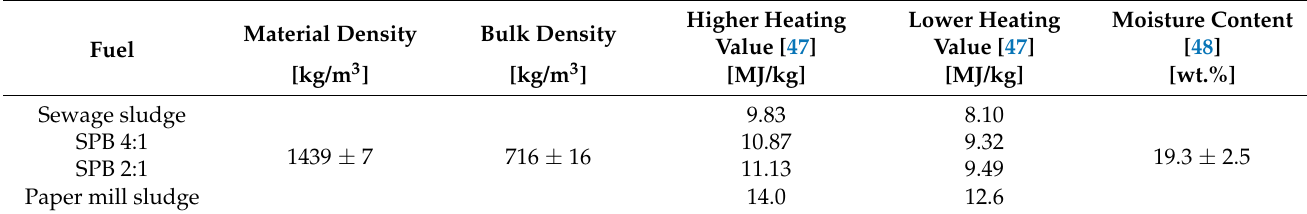
Table 1. Fuel properties (as delivered by